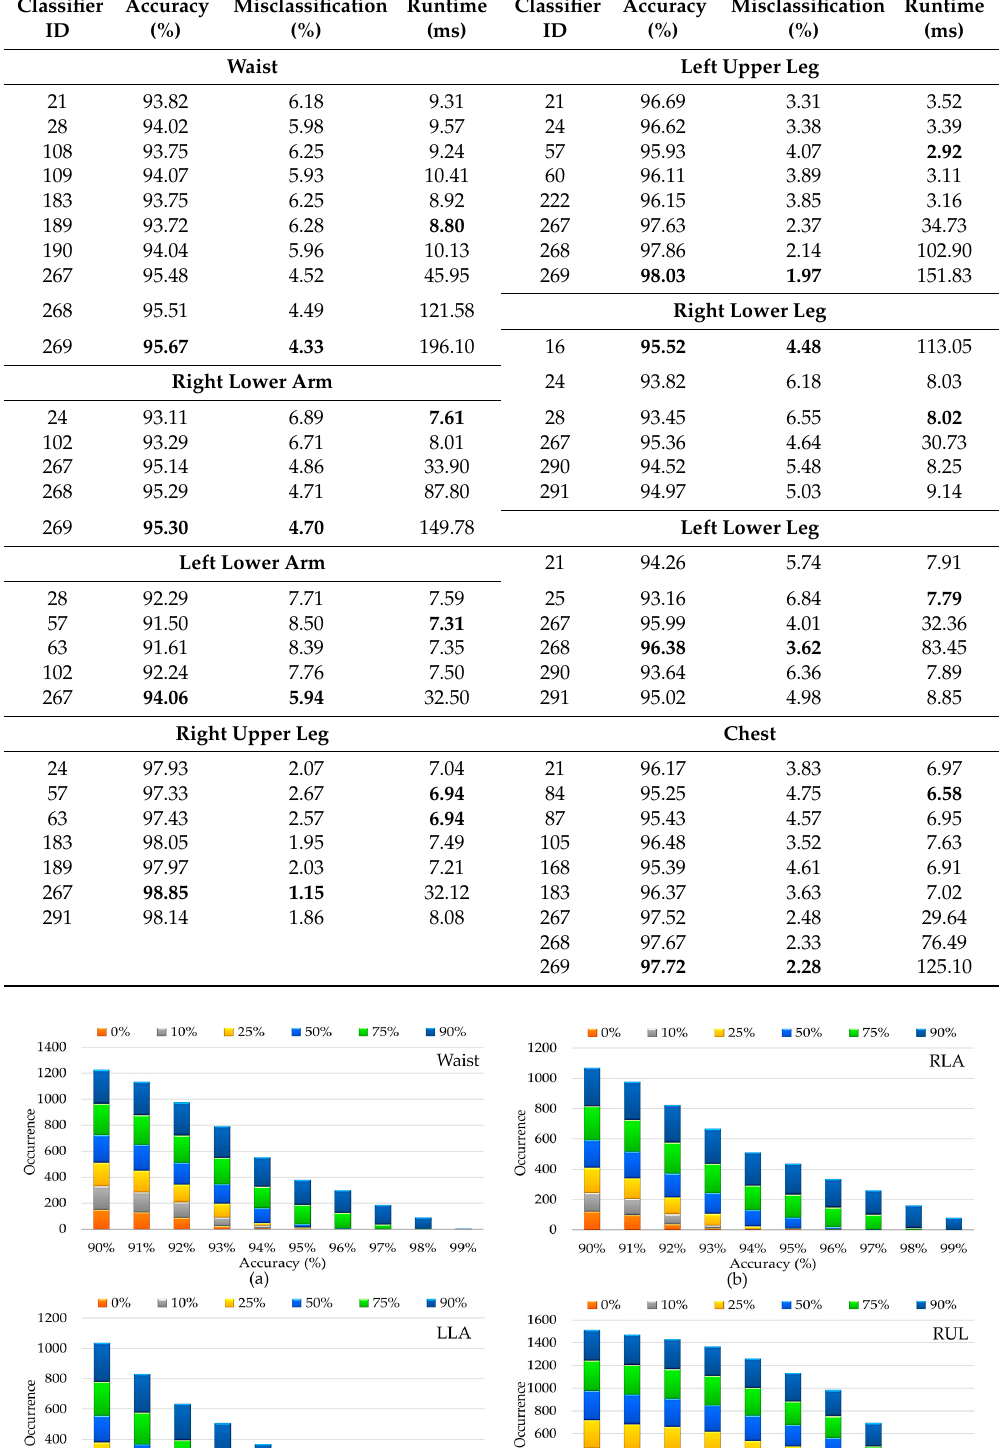
Table 3. The accuracy and runtime of non-dominated classifiers.